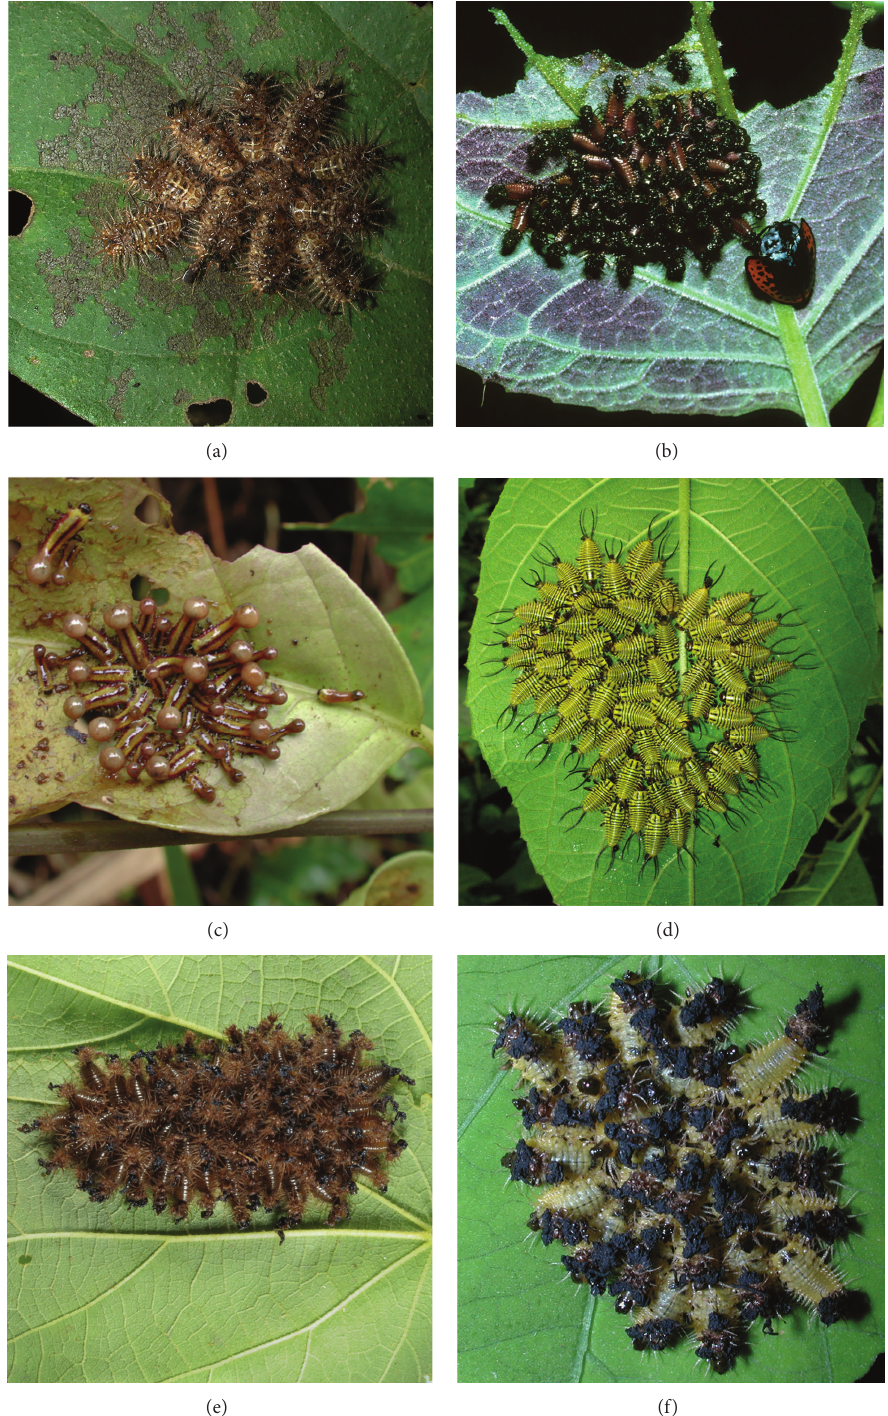
Figure 2: Cycloalexy in tortoisebeetle larvae. (a) Cistudinella foveolata (Ischyrosonychini) larvae on host Cordia alliodora (Ruiz & Pav.) Oken. Gamboa, Col´on Province, Panama; (b) Eugenysa coscaroni (Eugenysini) larvae and mother on host Mikania guaco Bonpl. (Asteraceae), Cerro Campana, Panama Province, Panama; (c) Nuzonia sp. on host Maripa nicaraguensis Hemsl., Chiriqu´ı Grande, Bocas del Toro Province, Panama; (d) Physonota alutacea (Ischyrosonychini) larvae on host Cordia spinescens L., Gamboa, Col´on Province, Panama; (e) Polychalma multicava (Goniocheniini) larvae on host Helicteres guazumaefolia Kunth. (Sterculiaceae), Gamboa, Col´on Province, Panama; (f) Stolas xanthospila (Mesomphaliini) larvae on host Turbina corymbosa (L.) Raf. (Convolvulaceae), Cerro Campana, Panama Province, Panama; all photographs © D.